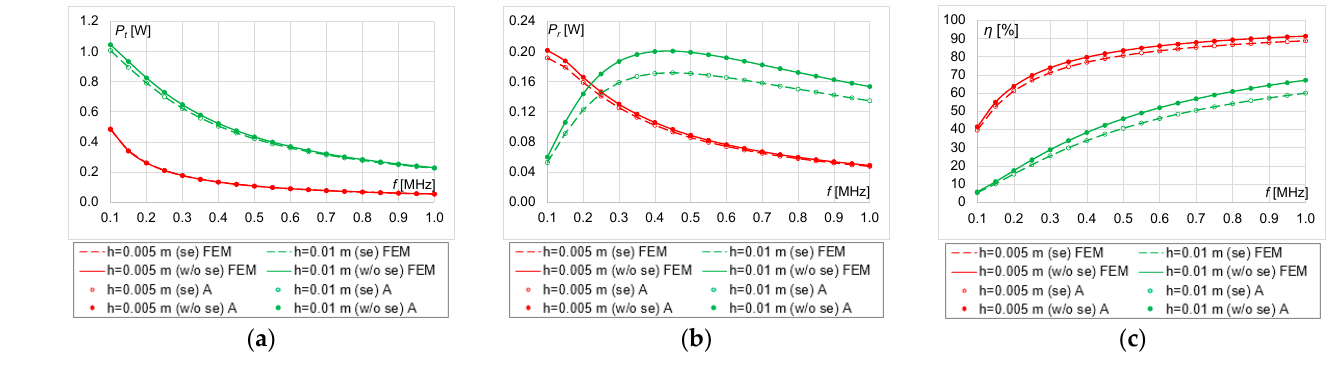
Figure 10. Results for n = 30 for the cases with and without skin effect: ( a ) P t , ( b ) P r , ( c ) η .